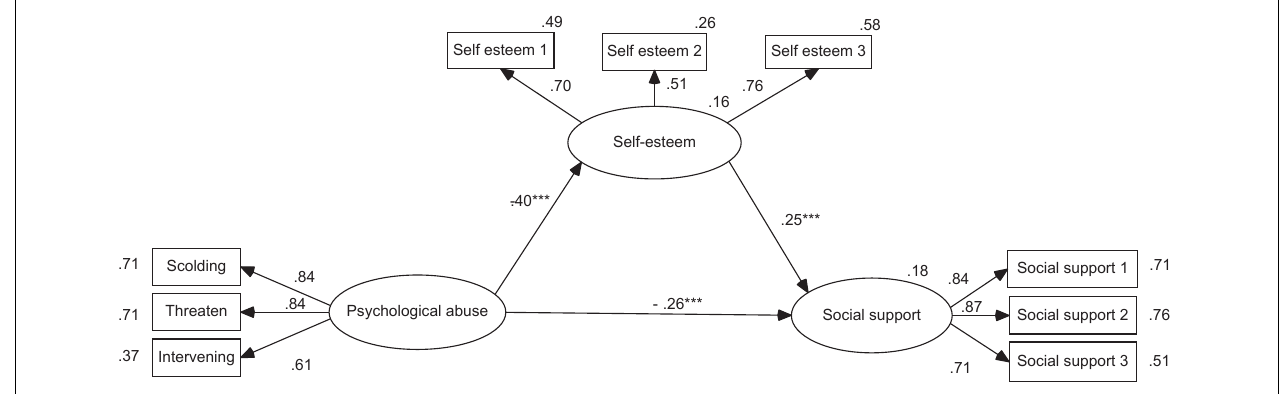
FIGURE 1 | Standardized parameter estimates of the structural model demonstrating effects of psychological abuse on social support via self-esteem. N = 417. *** p <